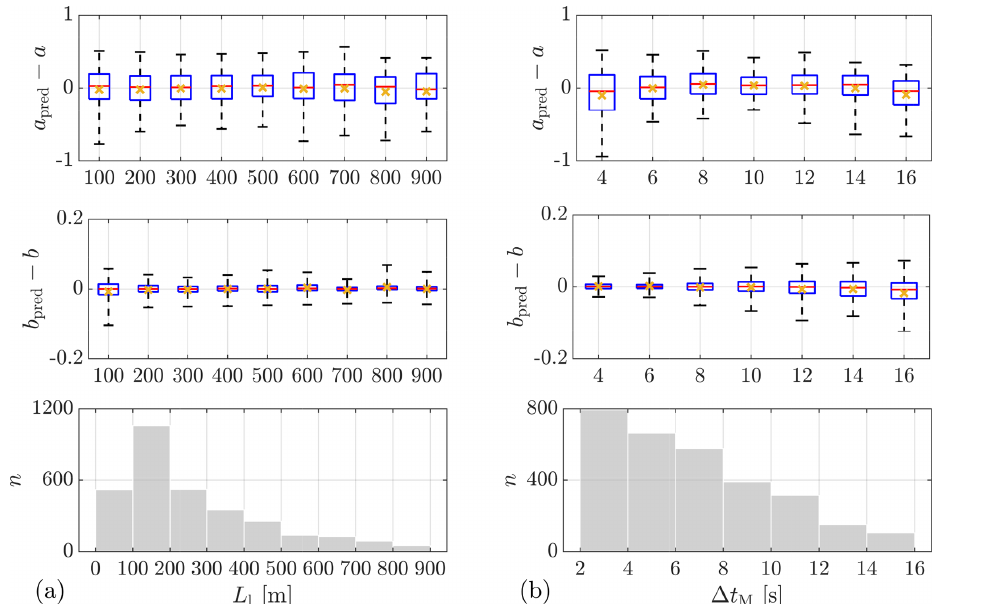
Figure 15. Prediction errors of a (case 6) and b (case 11) from Lidar Complex with respect to the values of predictors. (a) Integral length scale of lidar-measured wind speed L l . (b) Time lag determined by the peak of maximum cross-correlation (cid:49)t M . n is the sample size. The bottom and top of the boxes indicate the first and the third quartiles, i.e., 25th and 75th percentile, respectively. The lower and upper whiskers show the 5th and 95th percentiles. The red line and the yellow cross in the middle indicate the median and mean value, respectively.